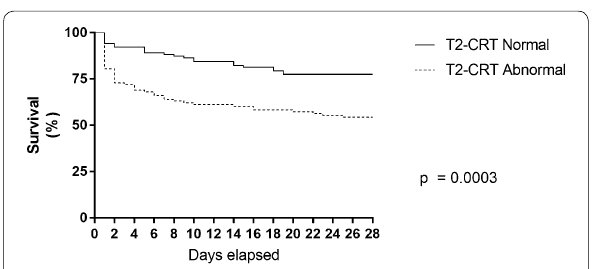
Fig. 1 Kaplan–Meier estimates of the 28‑day survival rate according to CRT status at 2